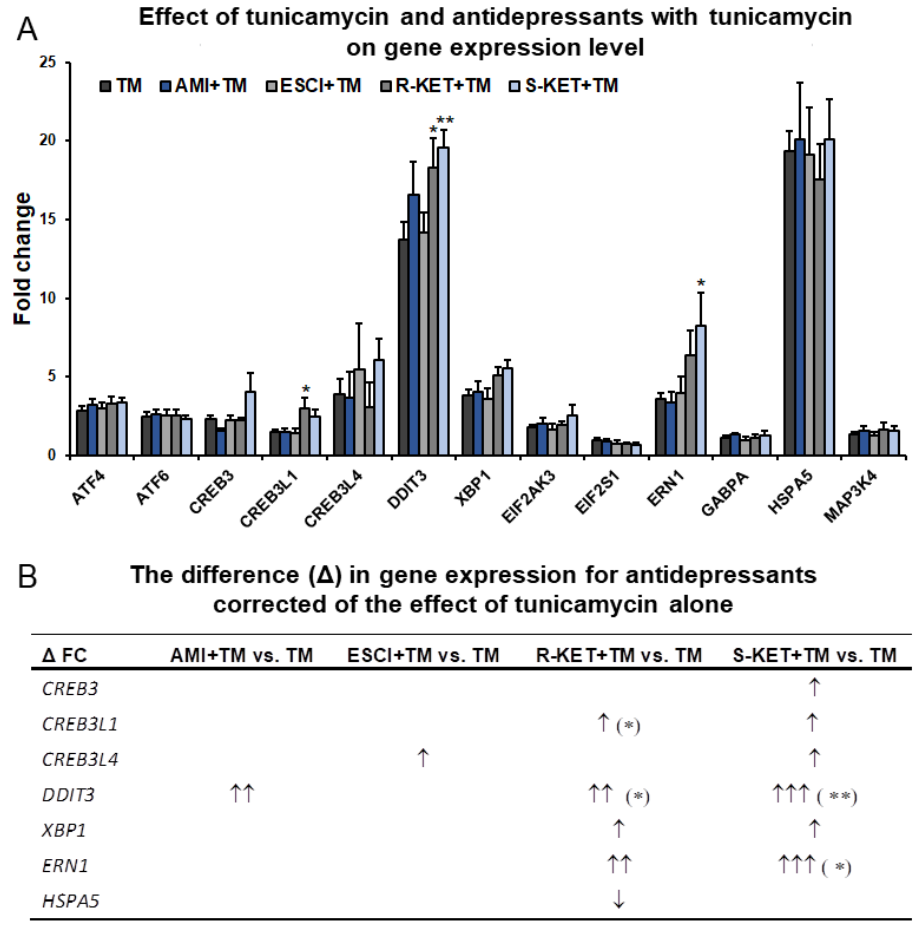
Figure 4. ( A ) Effect of tunicamycin (TM) with antidepressants (Ami—amitryptyline, Esci—escitalopram, R-ket—R-ketamine and S-ket—S-ketamine) and tunicamycin alone in astrocytes with regard to the expression of genes associated with ER stress. ( B ) To illustrate the difference ( ∆ ) in gene expression of antidepressants the symbols were introduced: ↑ for 1–2.5 fold change; ↑↑ 2.6–4.5 fold change; ↑↑↑ > 4.6 fold change. FC—fold change. Data are presented as the mean ± SEM and ex- pressed as fold change vs. untreated control cells. Statistical significance vs. tunicamycin-treated cells is indicated when appropriate; * p < 0.05; ** p < 0.01.